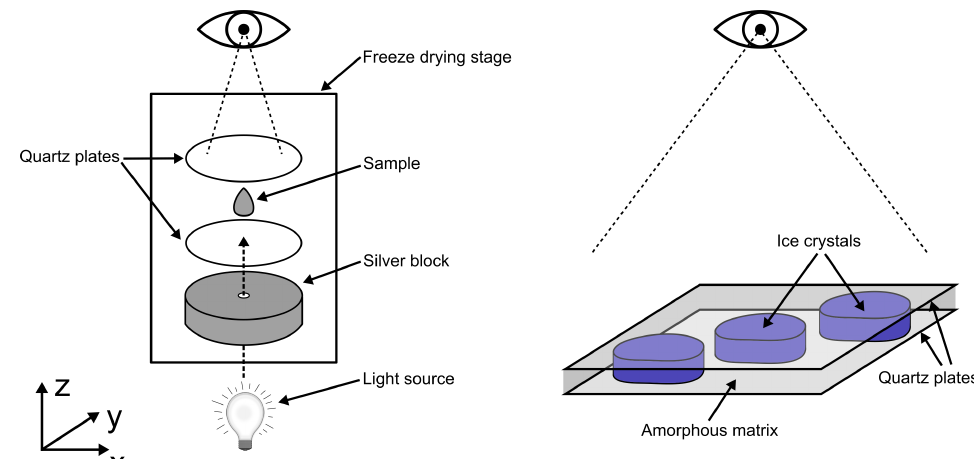
Figure 2. Schematic illustrations of the freeze-drying stage ( left ) and microscopic cutout of ice crystals (blue) embedded in the amorphous matrix (grey) in the experimental setup ( right